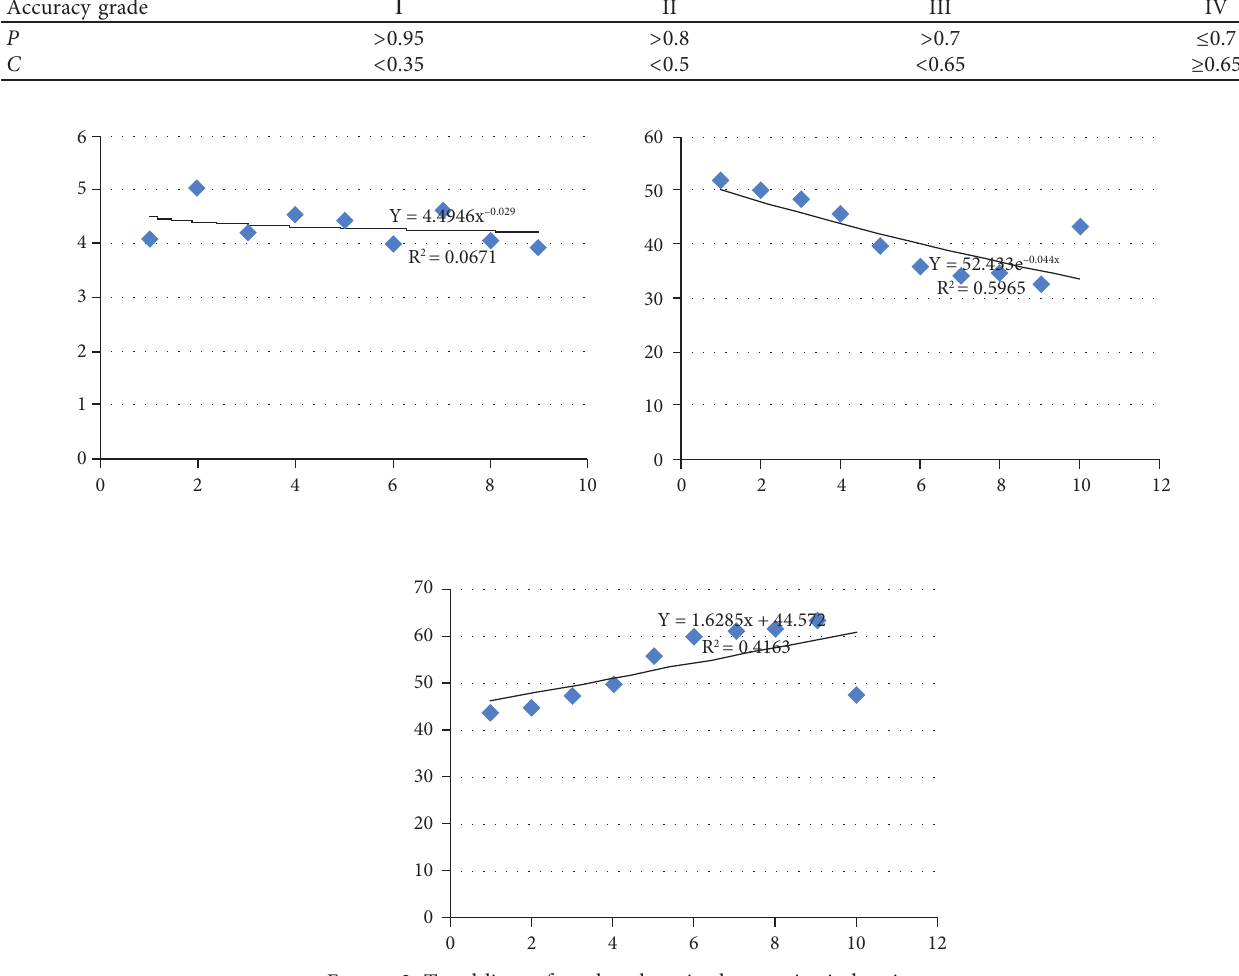
Figure 3: Trend lines of market share in three major